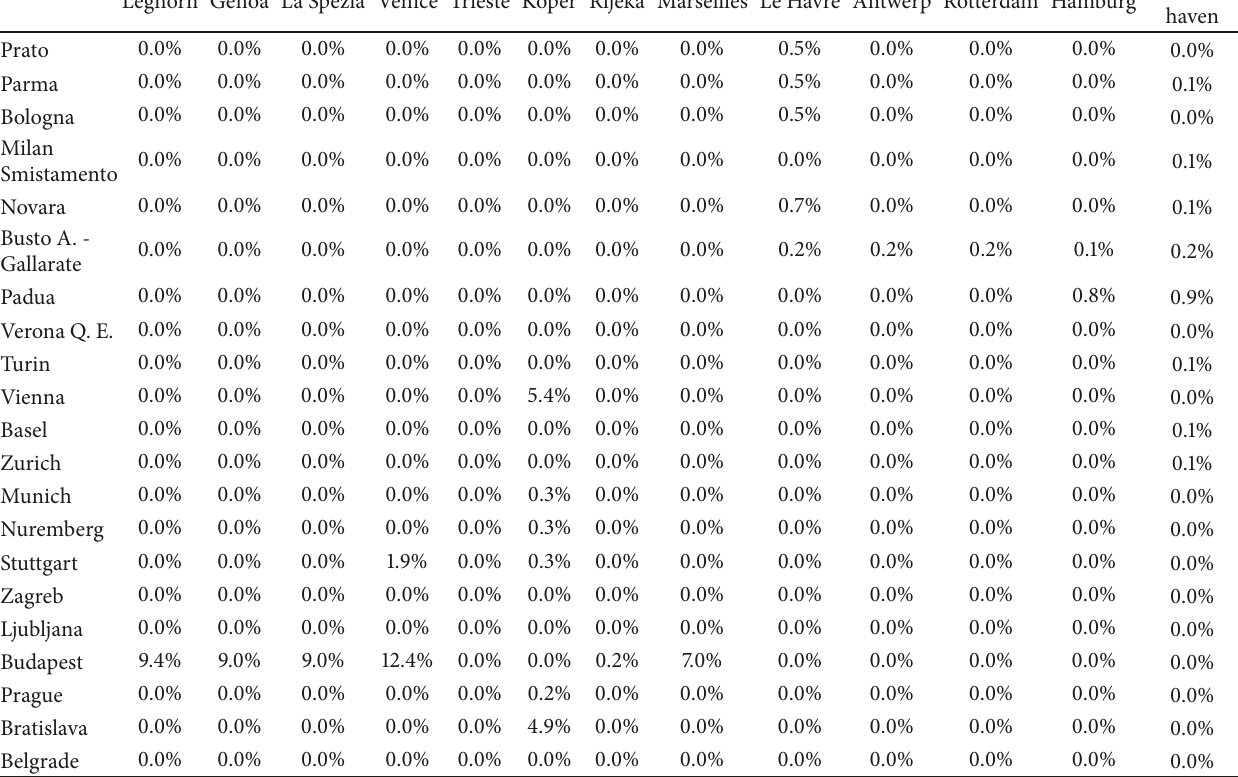
Table 7: Differences, in percentage,of monetary costs, between the optimisation by monetary costs and the optimisation by generalised costs (the optimisation by monetary costs is taken as